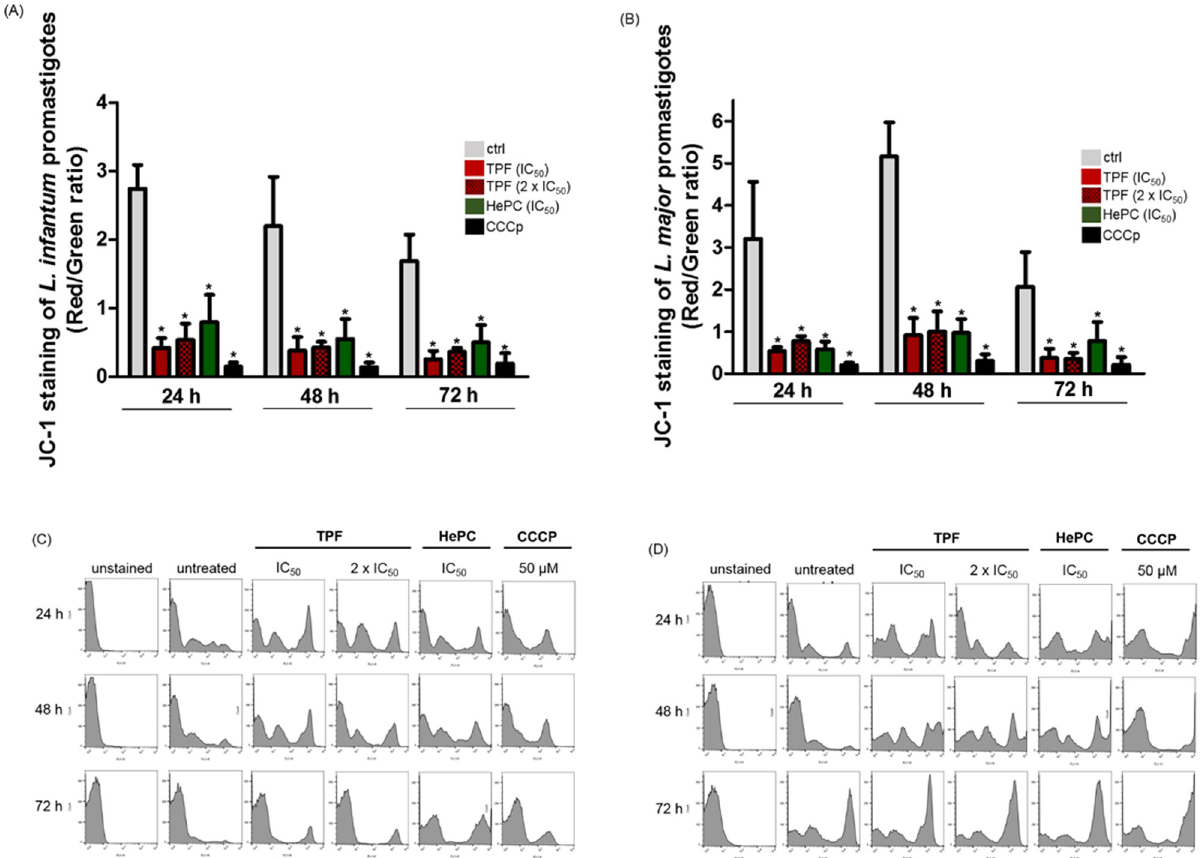
Fig 7. Evaluation of mitochondrial membrane potential in Leishmania spp. promastigotes treated with TPF.